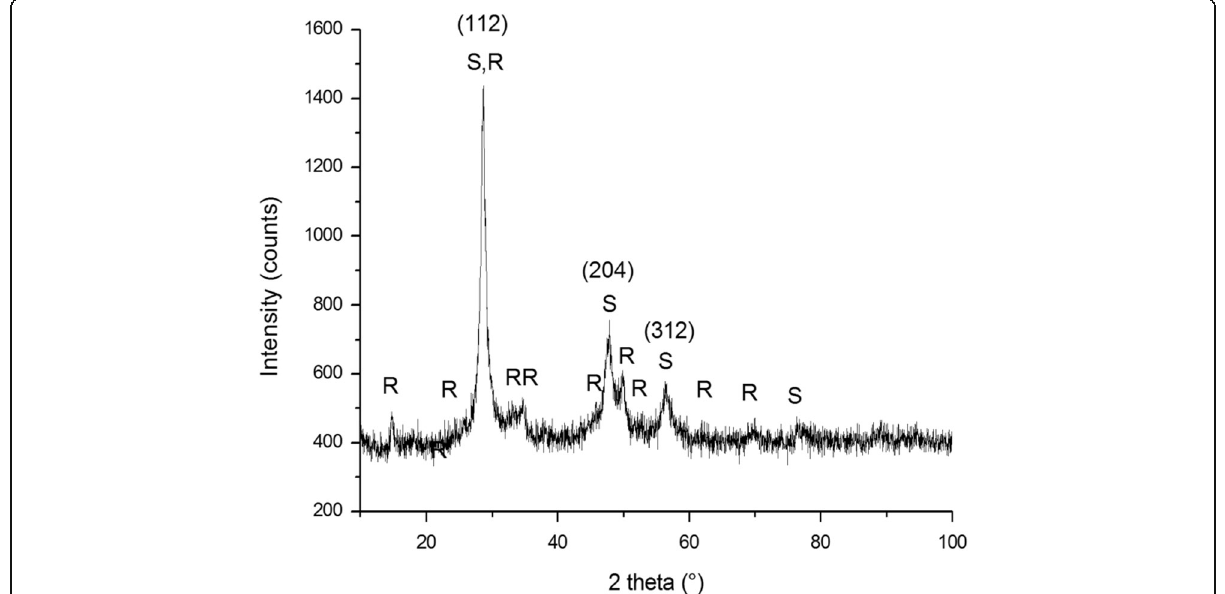
Fig. 1 XRD pattern of the CFTS sample: R rhodostannite Cu 2 FeSn 3 S 8 , S stannite Cu 2 FeSnS